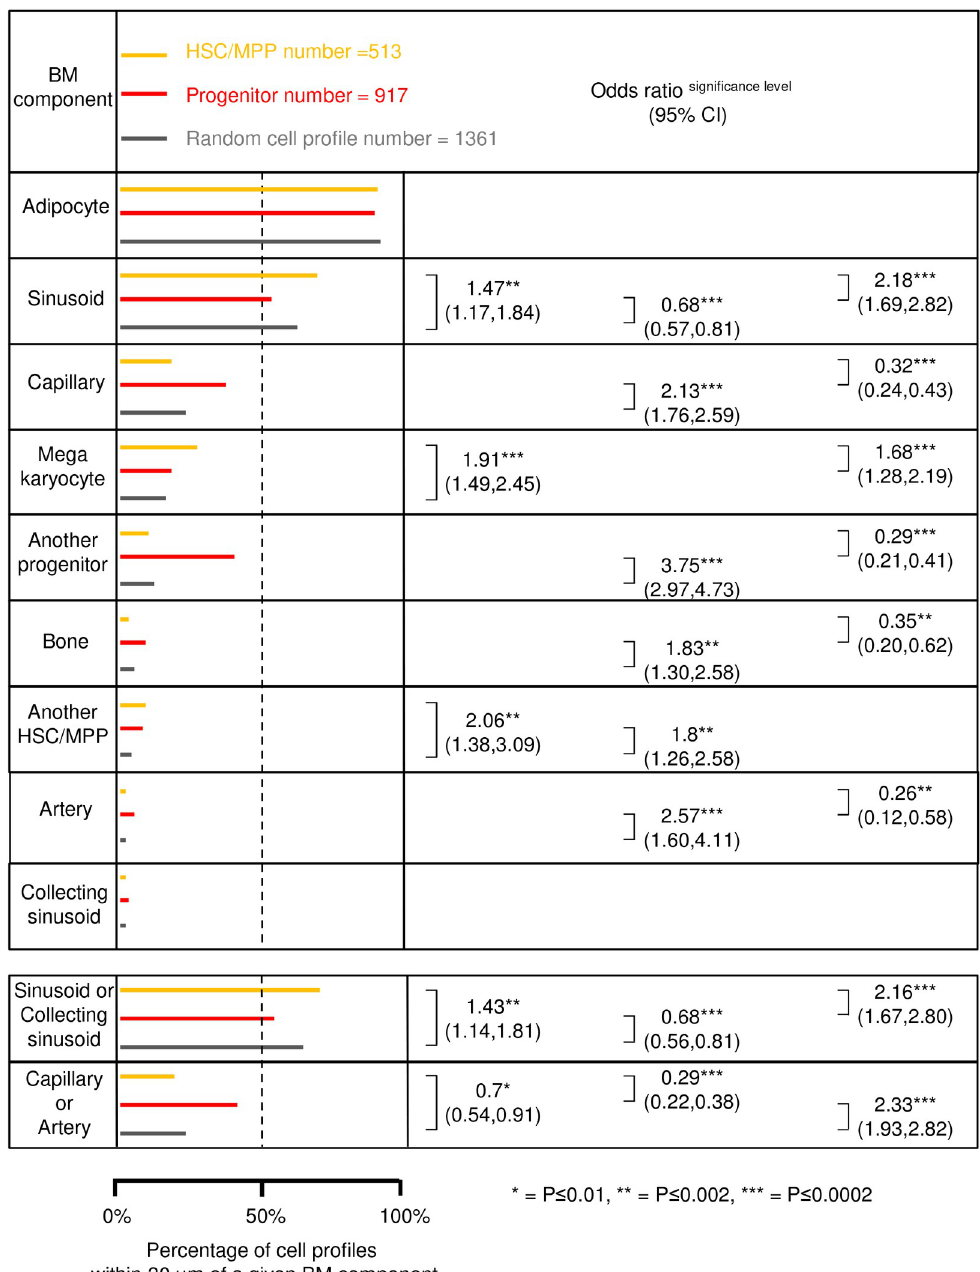
Fig 3. Relative likelihood of the HSCs/MPPs, the progenitors, and the random cell profiles to be in the presence of the indicated BM components. The length of the horizontal lines in yellow, red and grey shows the respective percentages of the HSCs/MPPs, the progenitors and the random cell profiles that show the indicated BM components within a distance of 30 μ m. The nine BM components are ranked according to the level of the random cell profile presence within a distance of 30 μ m, starting with the highest level of presence (adipocyte) and ending with the lowest level of presence (collecting sinusoids). Furthermore, the data for combination of sinusoids with collecting sinusoids, and of capillaries with arteries are also shown (at the lower part of the figure). The clustered logistic regression was used to compare the presence of each BM component (and the mentioned combinations) within a distance of 30 μ m from each of the three cell profile categories. These comparisons were performed in pairs: The HSCs/MPPs vs. the random cell profiles, the HSCs/MPPs vs. the progenitors and the progenitors vs. the random cell profiles. The biopsy number was 10, and the cell profile number was 2791 (513 + 917 + 1361), when comparing the HSCs/MPPs and the progenitors to the random cell profiles, and 1430 (513